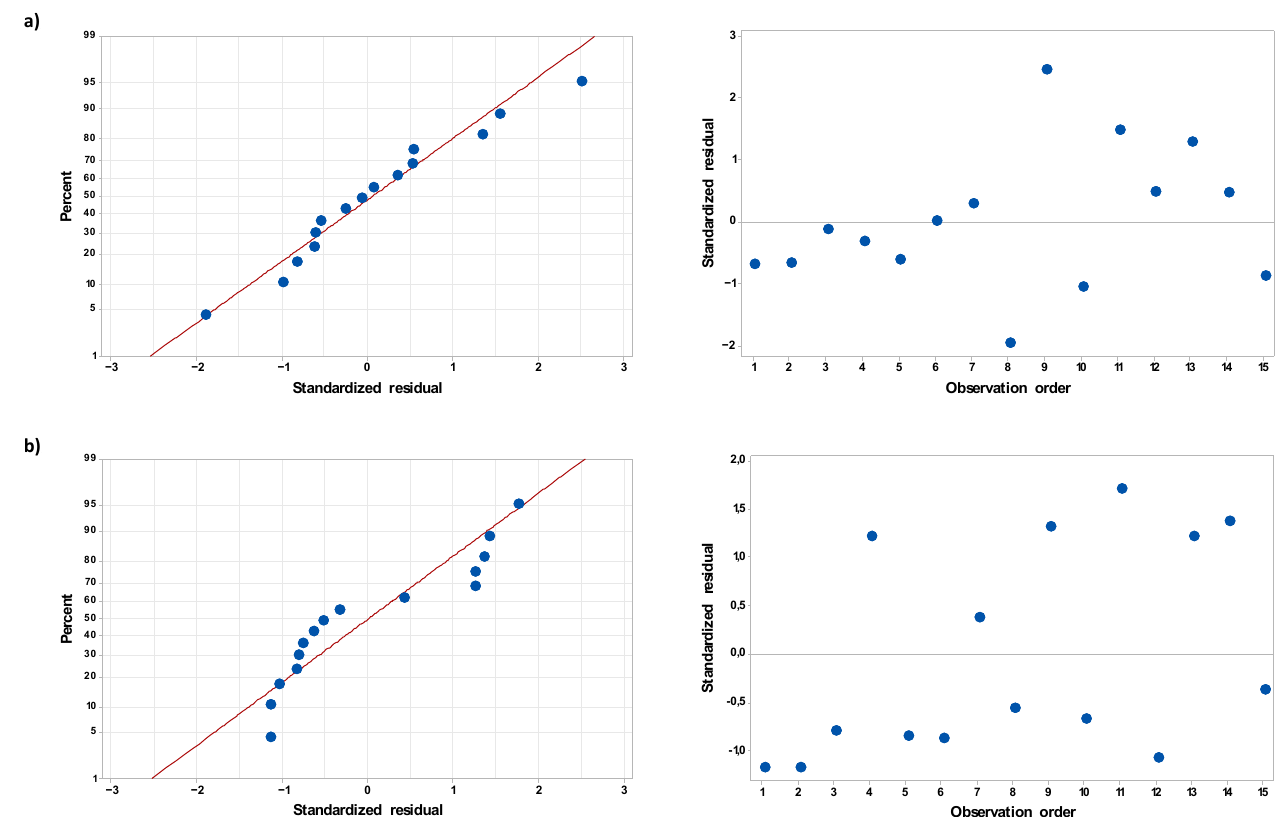
Figure 1. Normal probability plots and scatter plots of residuals versus observation (run) order for surface regression models predicting electrical conductivity of PALs produced using the continuous-flow FLC-dc-APGD system, as measured after ( a ) 1 h ( σ 1h ) and ( b ) 24 h ( σ 24h ).